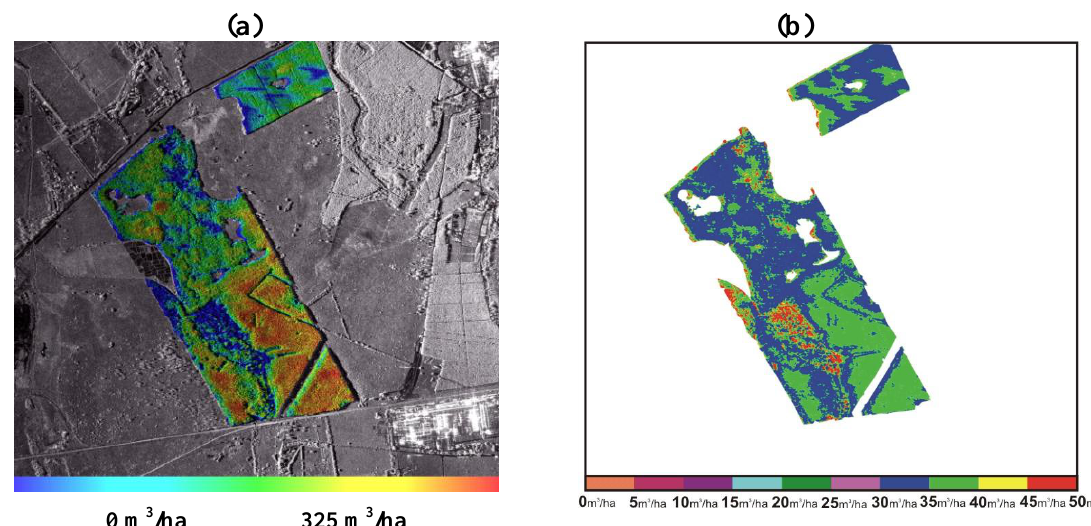
Figure 10. (a) IHS image of vegetation volume model (I = X band image, H = vegetation volume, S = vegetation mask); (b) Standard deviation